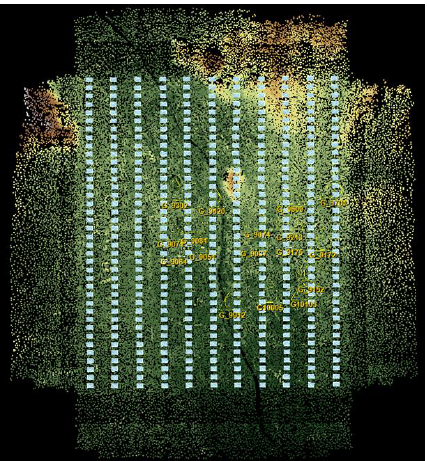
Figure 7 : Flight mission of UltraCam Osprey 4.1, GSD 5 cm,